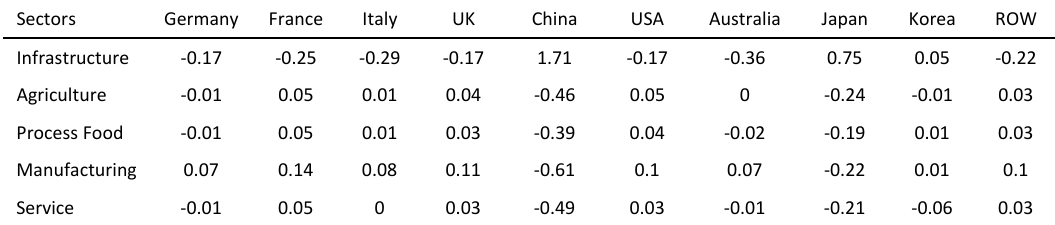
Table 5: Change in aggregate exports by sector (%)